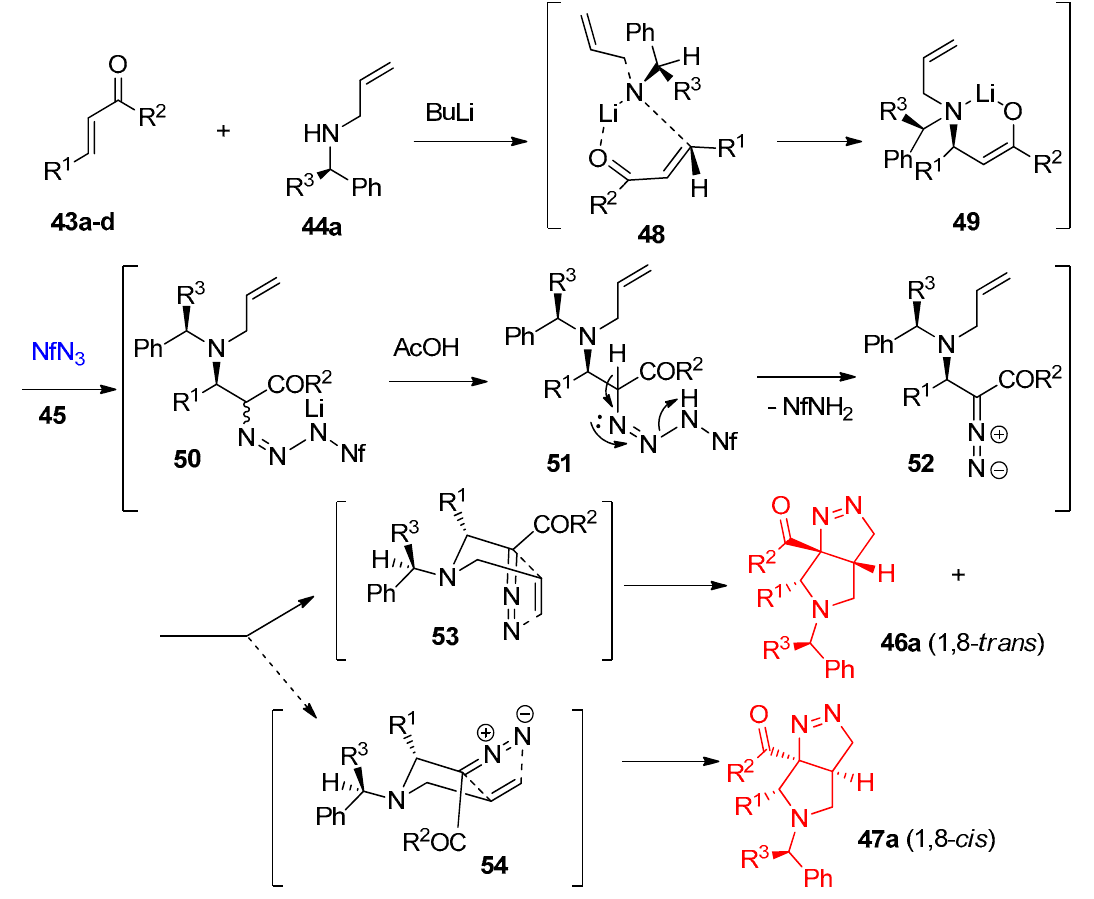
Scheme 27. The proposed mechanism for the formation of pyrrolotriazoles 46 and 47